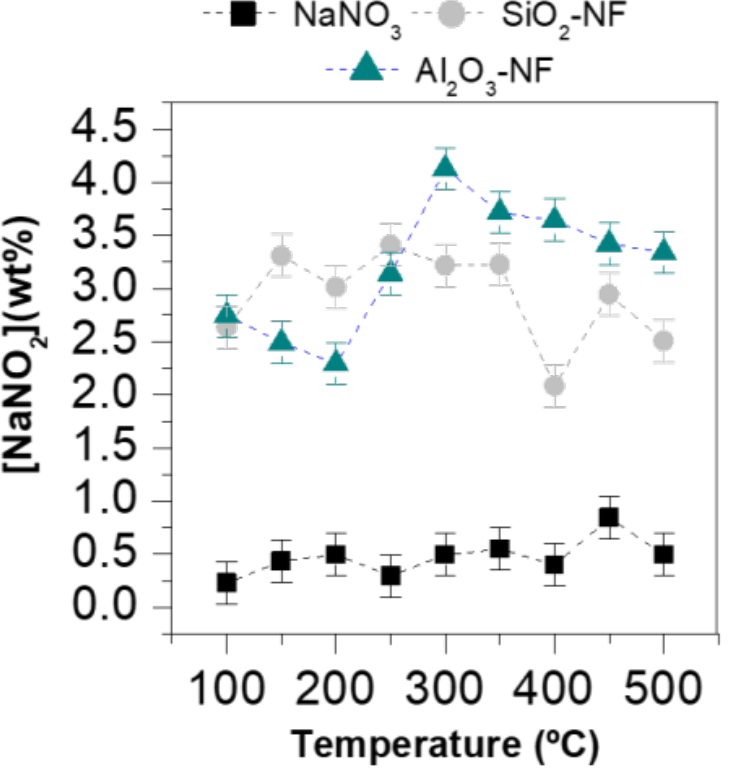
Figure 5. Nitrite concentration [NaNO 2 ] as a function of temperature from 100 to 500 ◦ C for pure 0.3M